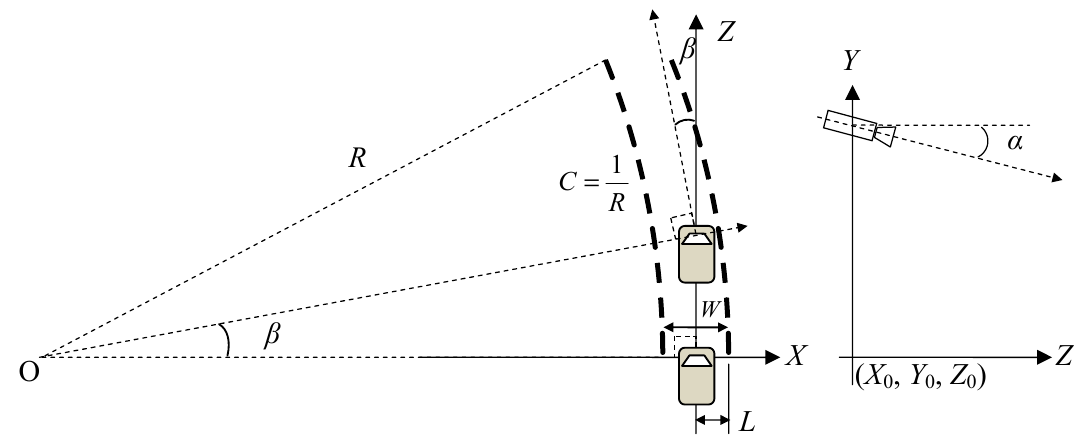
Figure 2. Installation layout of lane models and